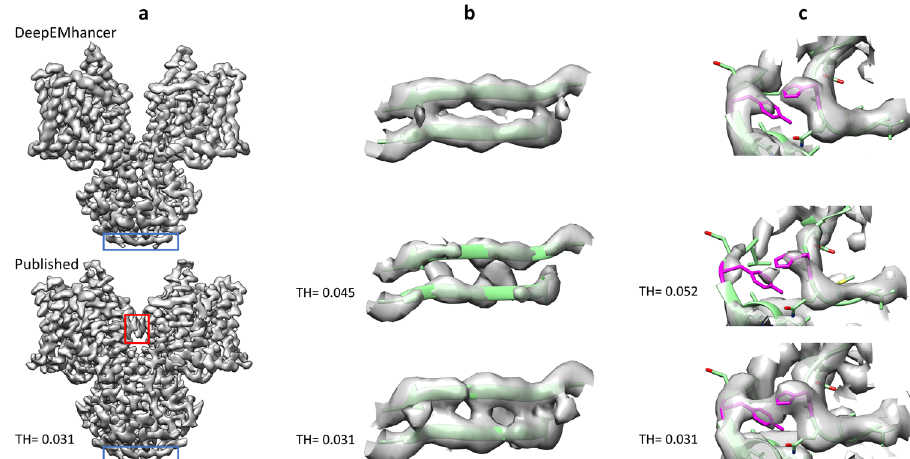
Fig. 5 DeepEMhancer results on testing map EMD-4997. a Overview of the published map ( B -factor sharpened, shown at the threshold recommended by the authors), bottom, and the map obtained with DeepEMhancer, top. Red box highlights an artifact that has been automatically removed by DeepEMhancer. Blue box delimits the region showed in b . b Zoom-in of the region marked with a blue box that contains the β -sheet R7-A10, chains A and B. The published volume is shown at the recommended threshold and at the threshold at which the backbone begins to look discontinuous. As it can be appreciated, the DeepEMhancer solution resolves better than the published map of the two strands of the sheet. c Zoom-in of the region centered at chain B residues H121 and Y361 (colored in magenta). The published volume is shown at the recommended threshold and at the smaller threshold at which the density that connects the two residues disappears. As it can be appreciated, DeepEMhancer post-processed map resolves better than the published map of the two residues.